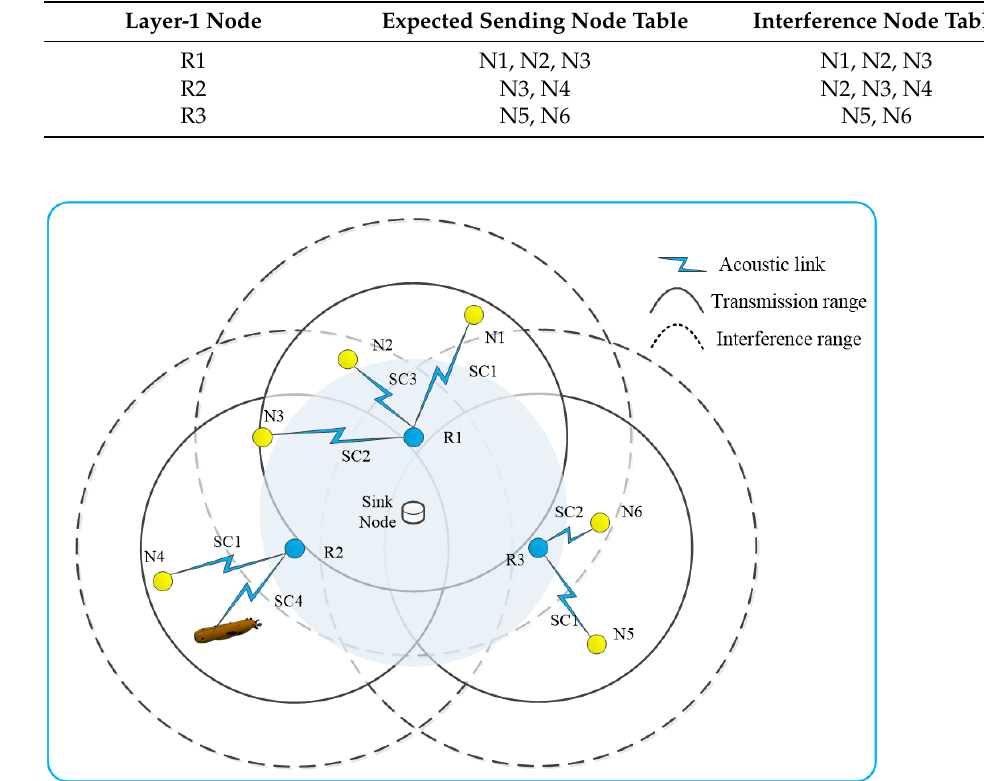
Figure 6. Interference diagram of channel allocation for the second layer